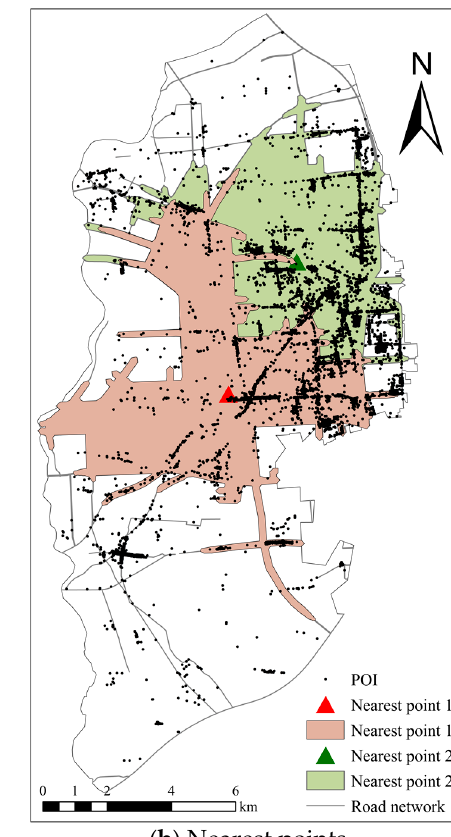
Figure 6. Coverage of POIs.